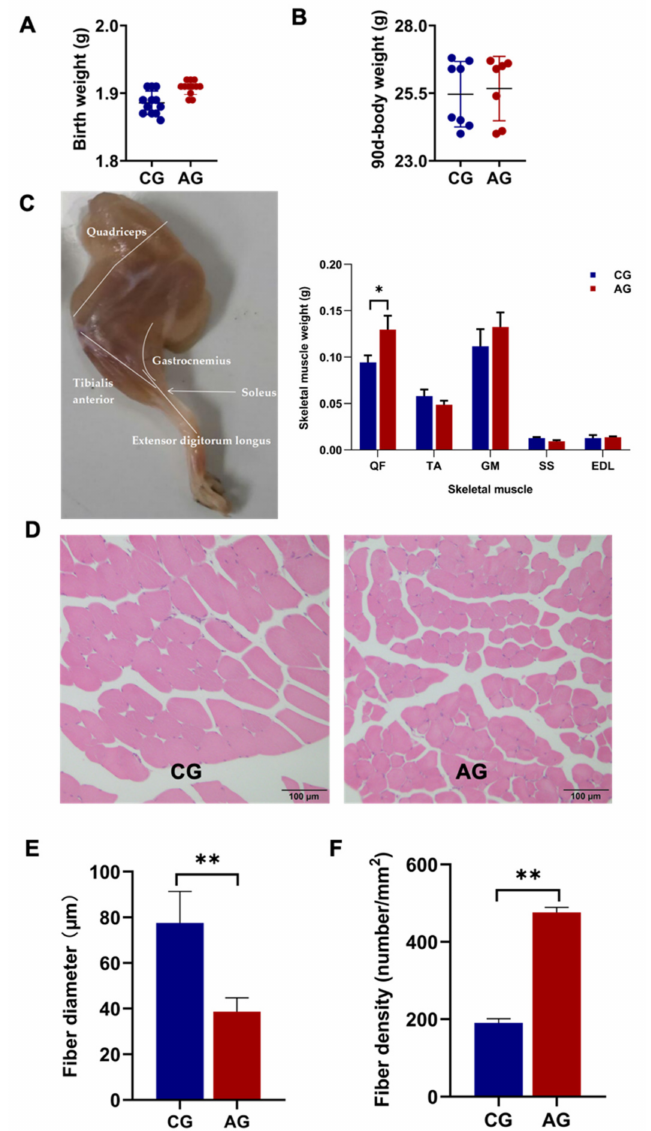
Figure 6. Body weight and skeletal muscle histological characteristics of mice. ( A ) Birth weight. ( B ) 90-day body weight. ( C ) The weights of quadriceps femoris (QF), tibial anterior muscle (TA), gastrocnemius (GM), soleus (SS), and extensor digitorum longus (EDL). ( D ) HE staining (original magnification, × 200) showed the fiber size of quadriceps femoris. ( E ) The fiber diameters and ( F ) densities in quadriceps femoris. The data were expressed as the means ± SEM; * p < 0.05, ** p <